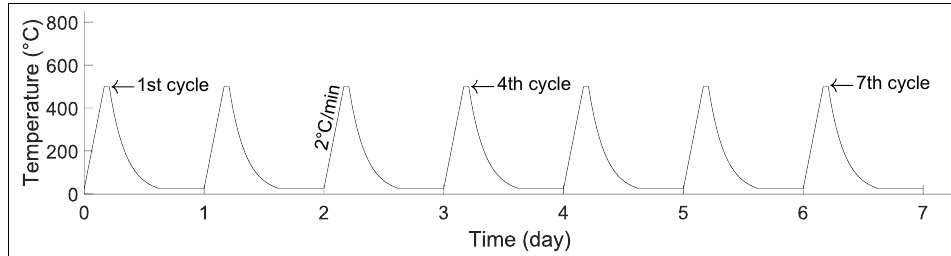
Figure 5. Temperature cycles used to test Transducer C.